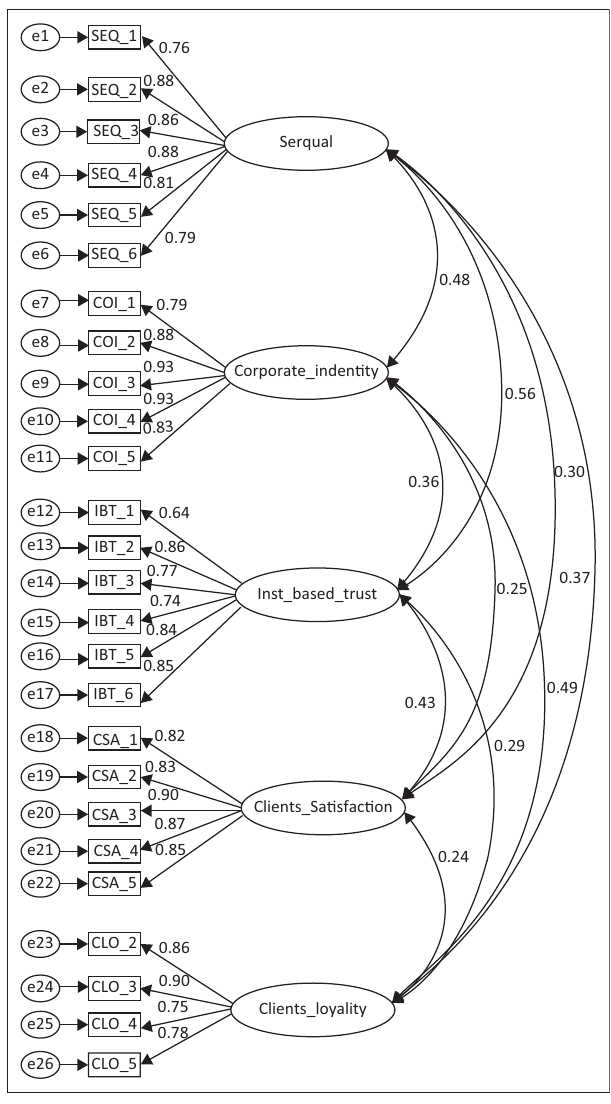
FIGURE 2: AMOS graphics output for convergent and discriminant validity.